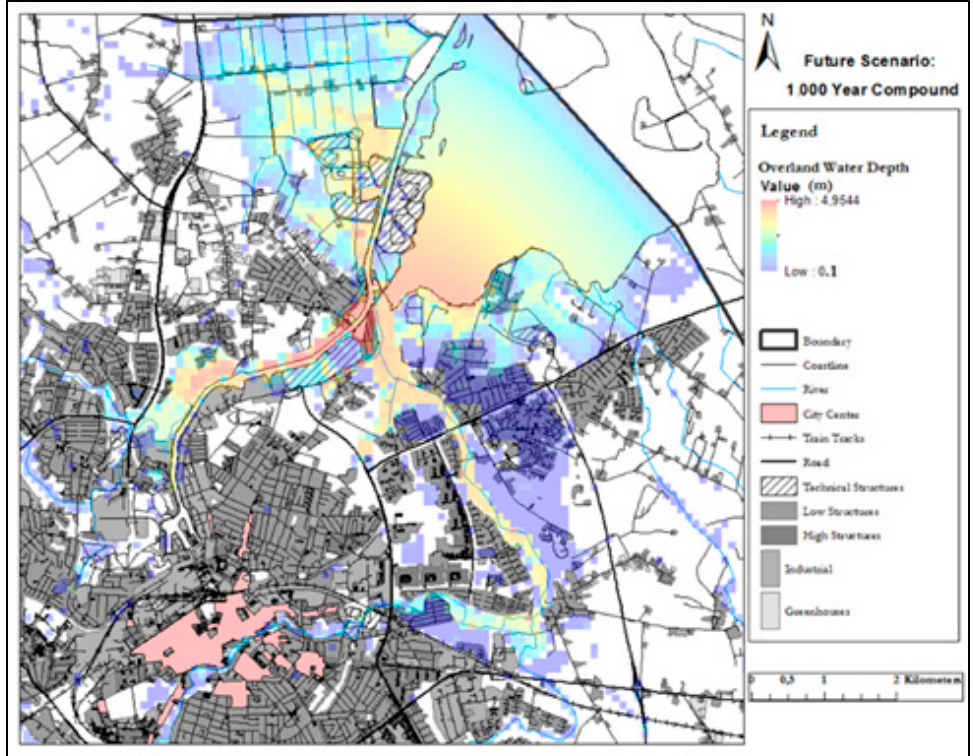
Figure 11. Scenario of potential climatic coincidence of increased runoff in Odense River and increased sea level in Odense Fjord. Resultant flooding (yellow to red) is observed along downstream part of Odense River [37].